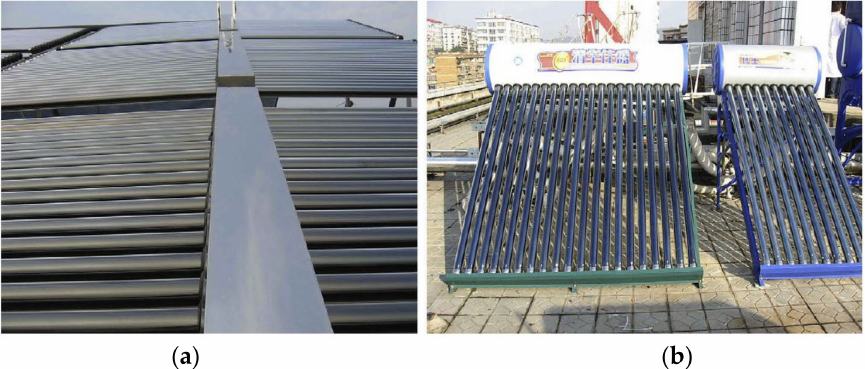
Figure 7. ( a ) H-shaped collectors ( b ) T-shaped collectors (Tang et al.,